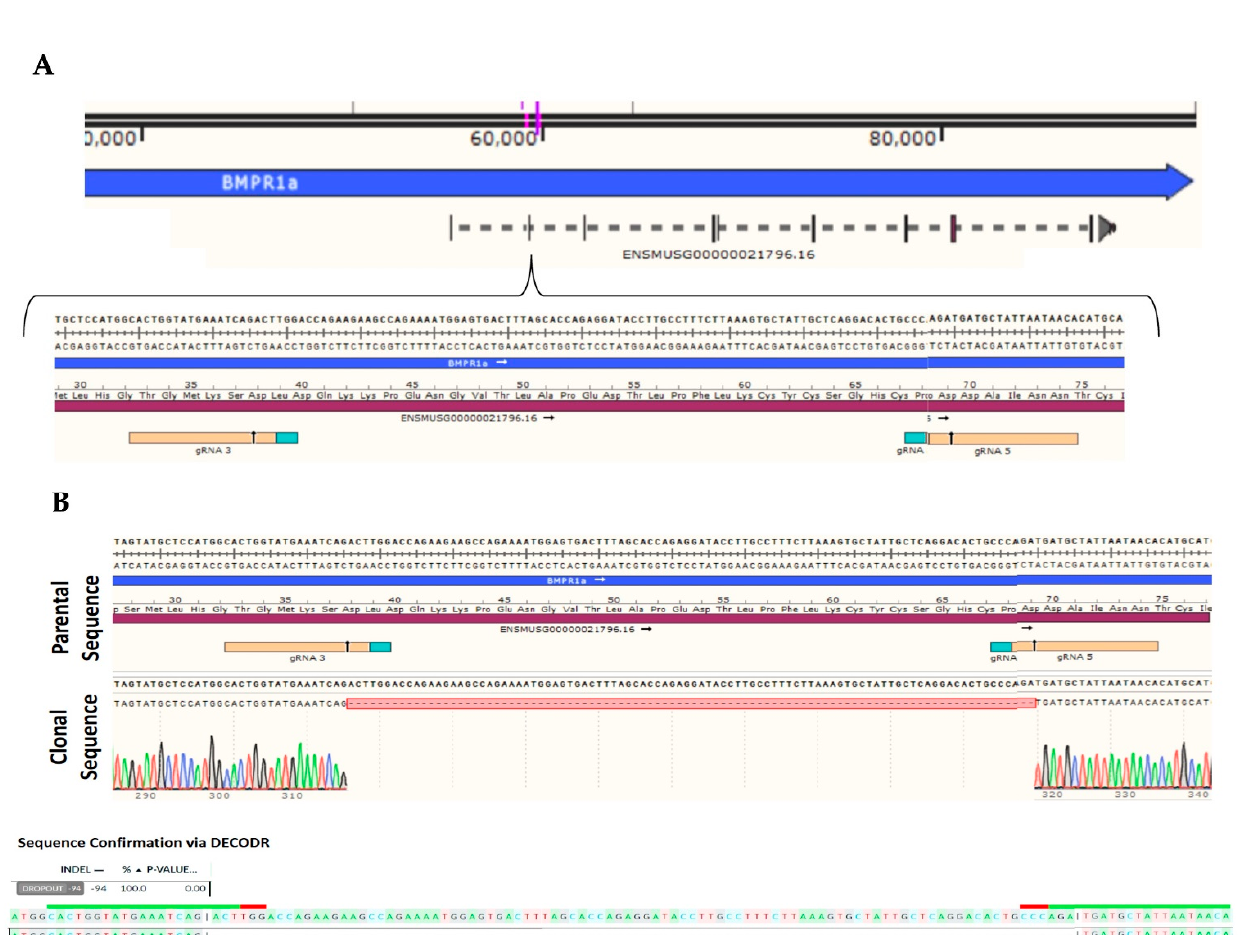
Figure 1. Creation of a BMPRIa Knockout (KO) in the C2C12 cell line. ( A ) In this exon 2 dual guide design, two gRNAs were designed to guide Cas9 to exon 2 within BMPRIa . gRNAs 3 and 5 induced a frameshift deletion of 94 base pairs, causing an abrupt stop downstream in the codon. ( B ) In KO clone 4, BMPRIa contained a 94 base pair deletion between amino acids 38 (asparagine) and 69 (asparagine). An early stop codon was induced, and DECODR data demonstrated that 100% of the population contained the KO.